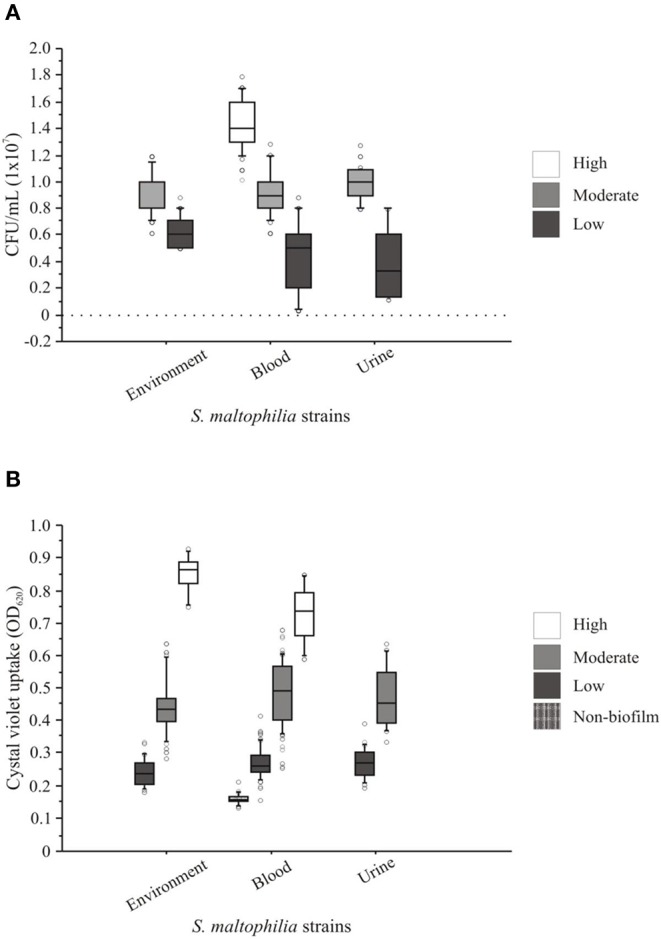
Adherence and biofilm patterns of clinical and environmental strains of S. maltophilia. (A) The adhesion assays were performed with human bladder HTB-9 cells. (B) The biofilm assays were based on the spectrophotometric quantification of the methanol retained by the 96-well microplate biofilm. The points outside the boxes represent the values of adhesion and biofilm formation outside the quartiles.